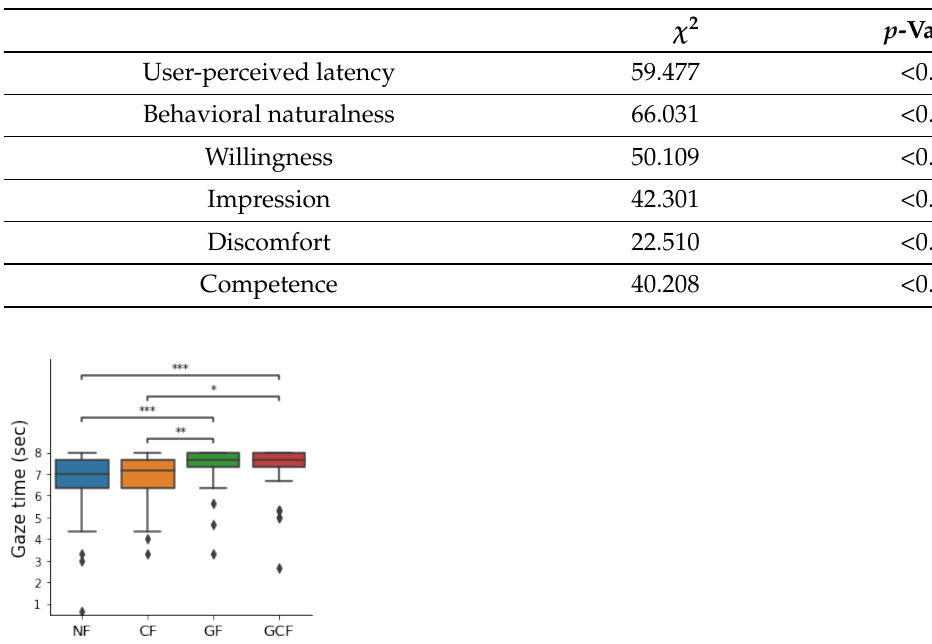
Figure 8. Results of the subjective measures: ( a ) user-perceived latency, ( b ) behavioral naturalness, ( c ) willingness, ( d ) impression, ( e ) discomfort, and ( f ) competence. (*: p < 0.05, **: p < 0.01, ***: p < 0.001). Table 3. Summary of the Friedman test results.